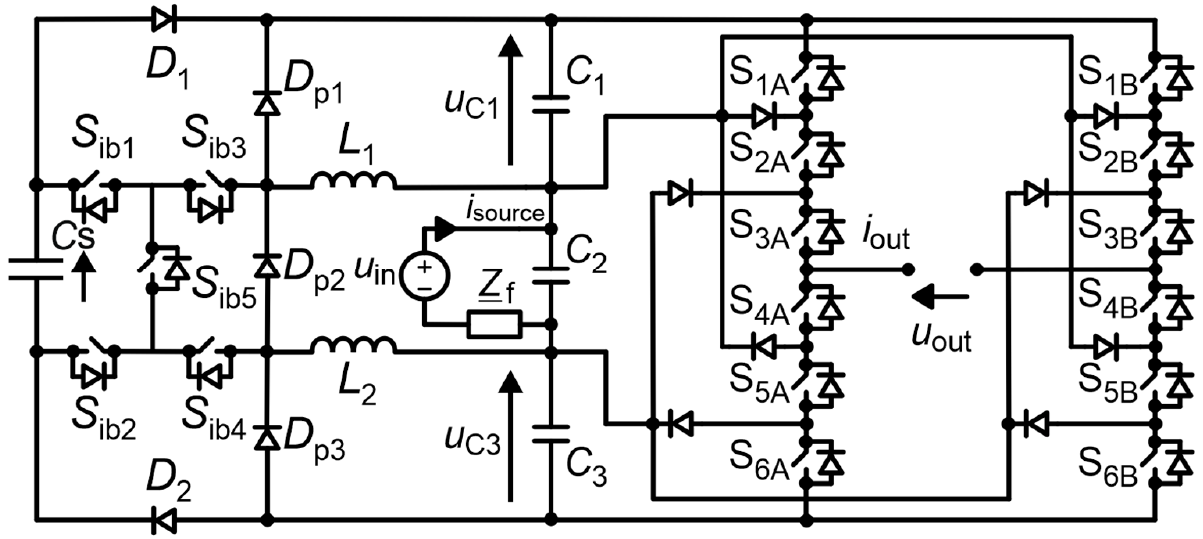
Figure 1. The basic concept of the DC-AC system.